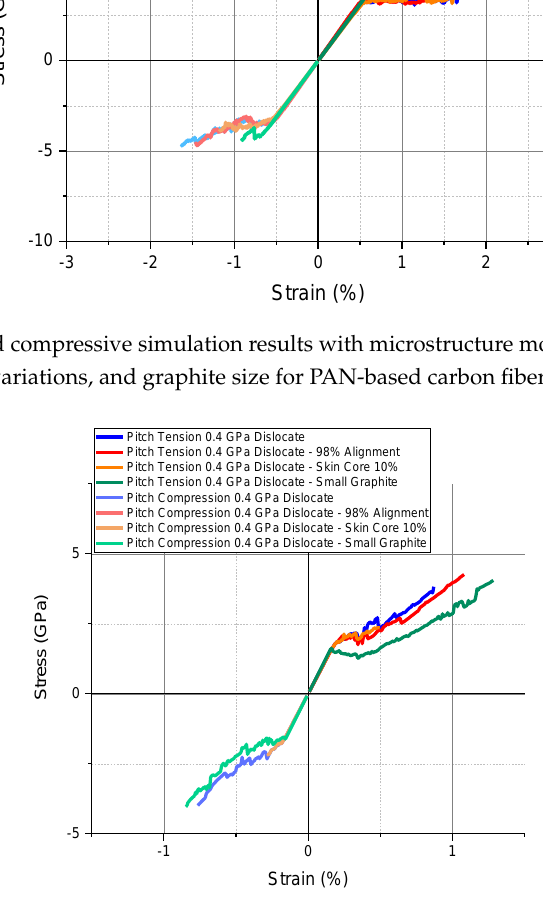
Figure 13. Tensile and compressive simulation results with microstructure modifications of alignment, skin-core alignment variations, and graphite size for pitch-based carbon fibers.